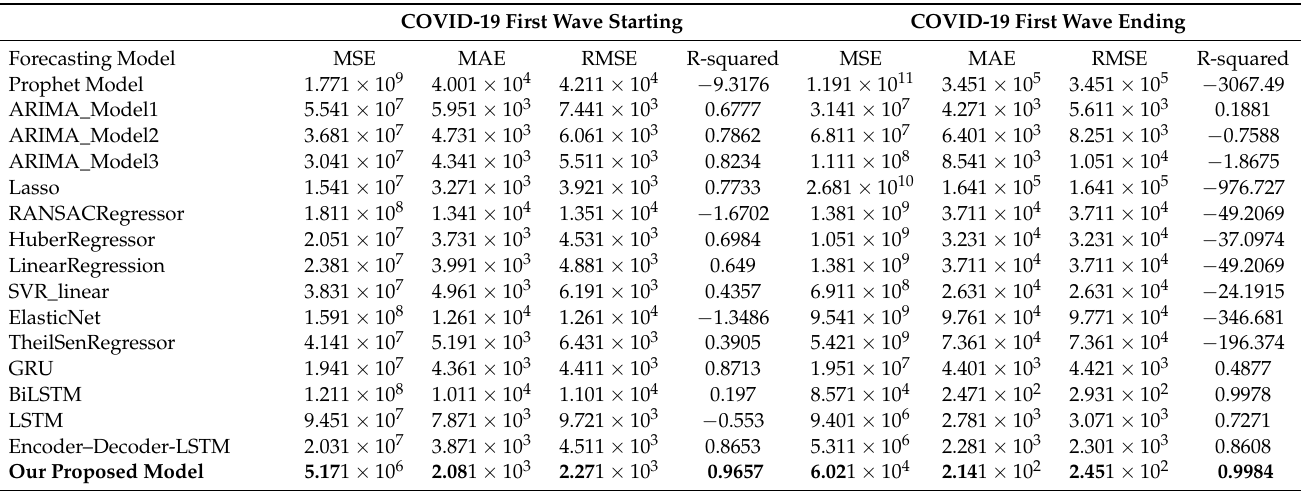
Table 3. A comparative analysis of our proposed approach with the previous methods based on statistical evaluation criteria for recovered cases in Saudi Arabia.